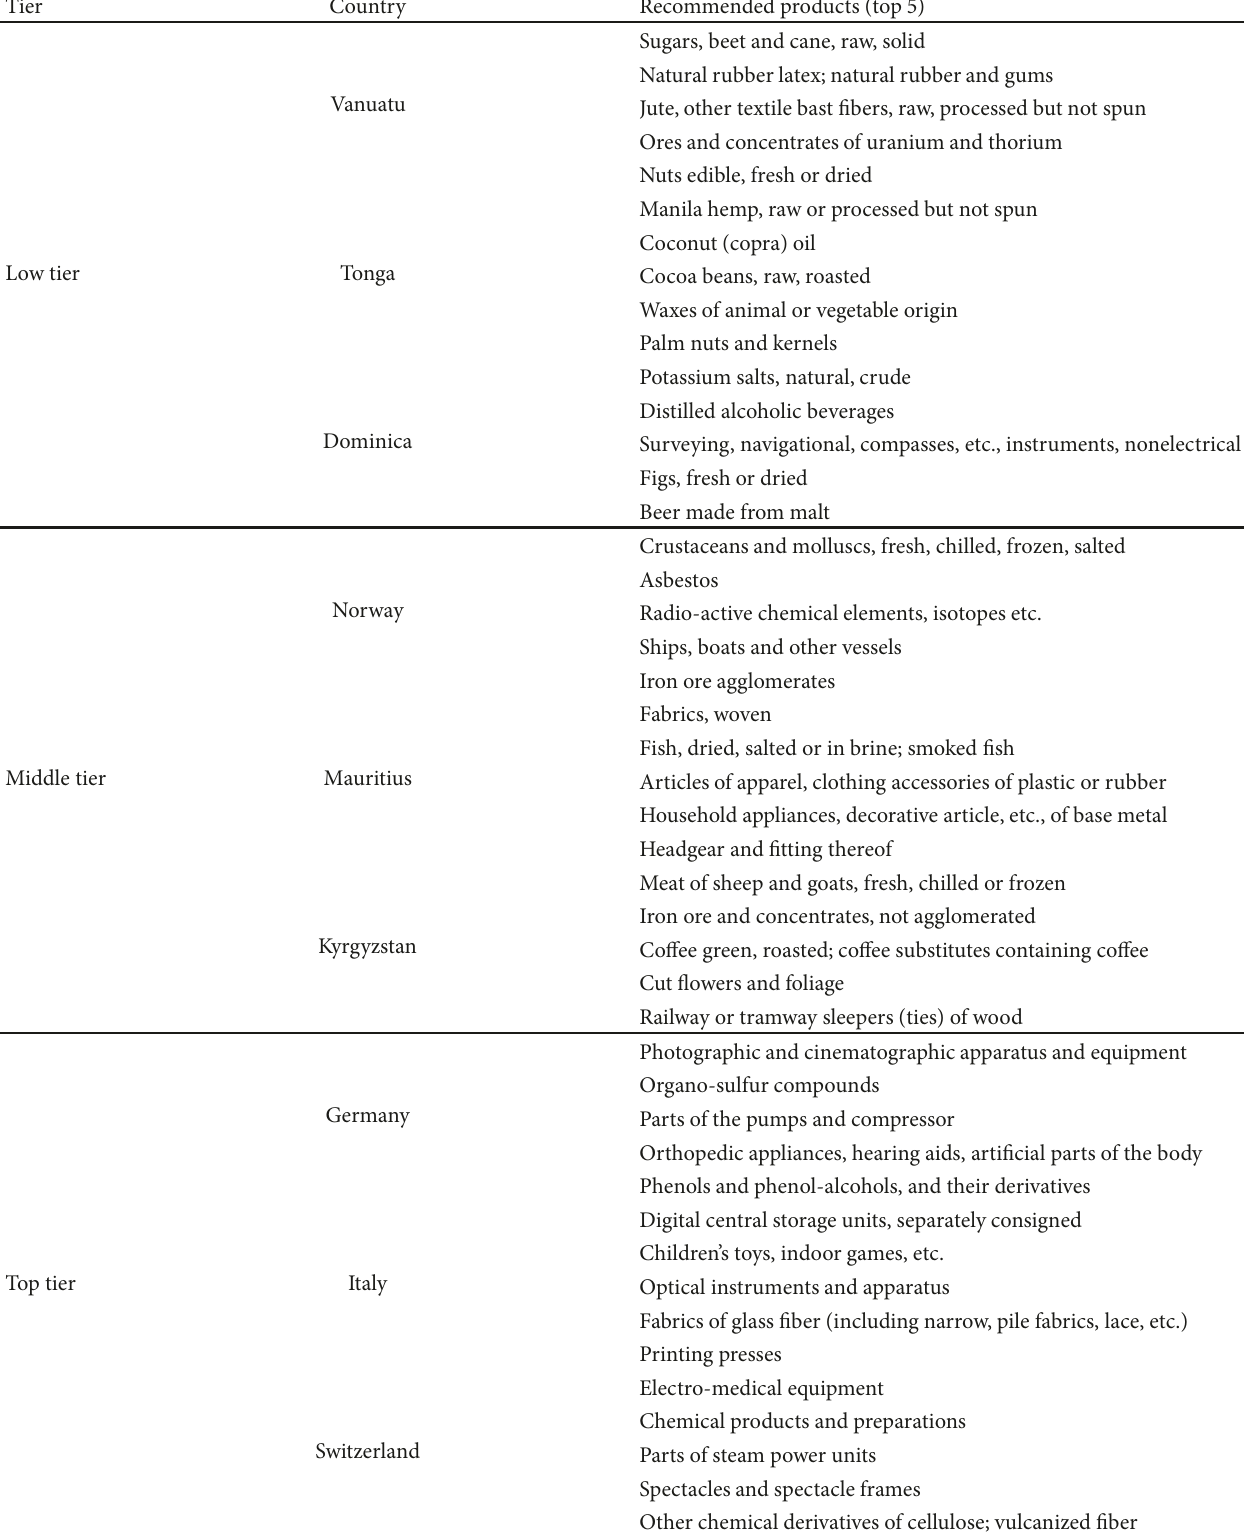
Table 2: The top five recommended products by HeatS algorithms for three randomly selected countries in different